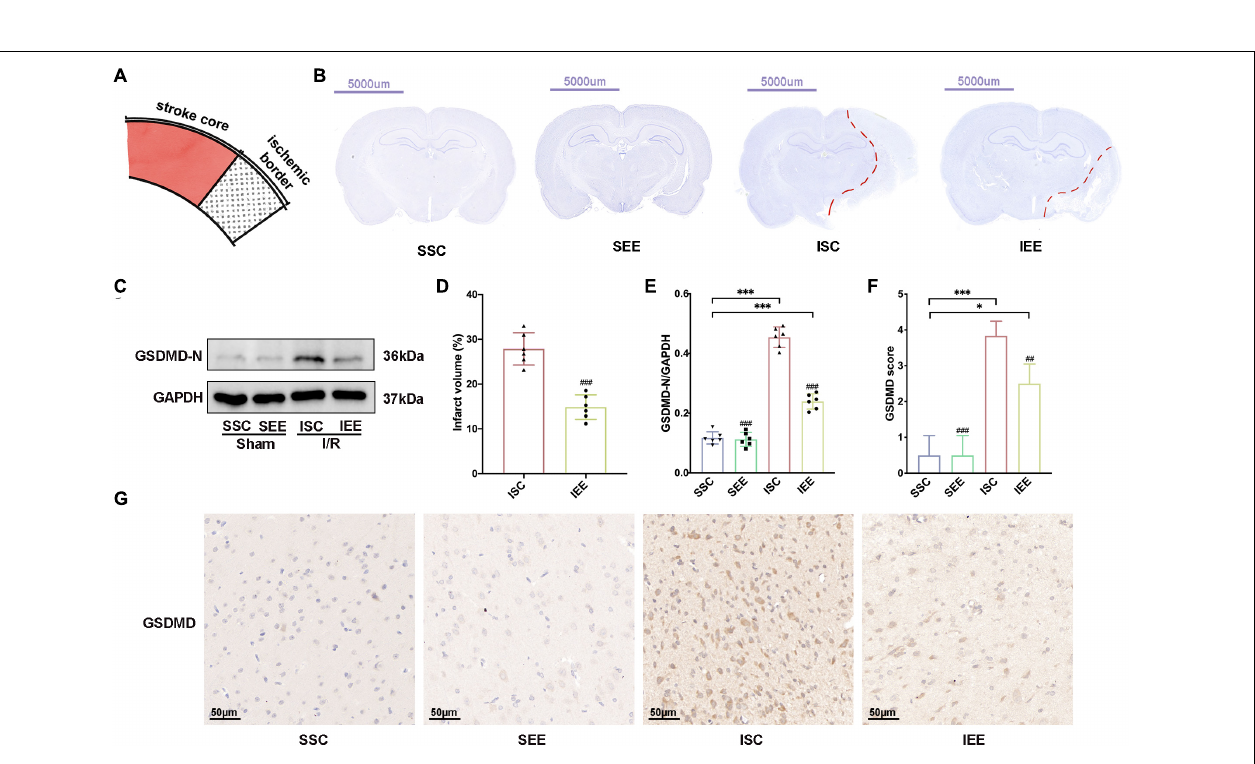
Frontiers in Aging Neuroscience |